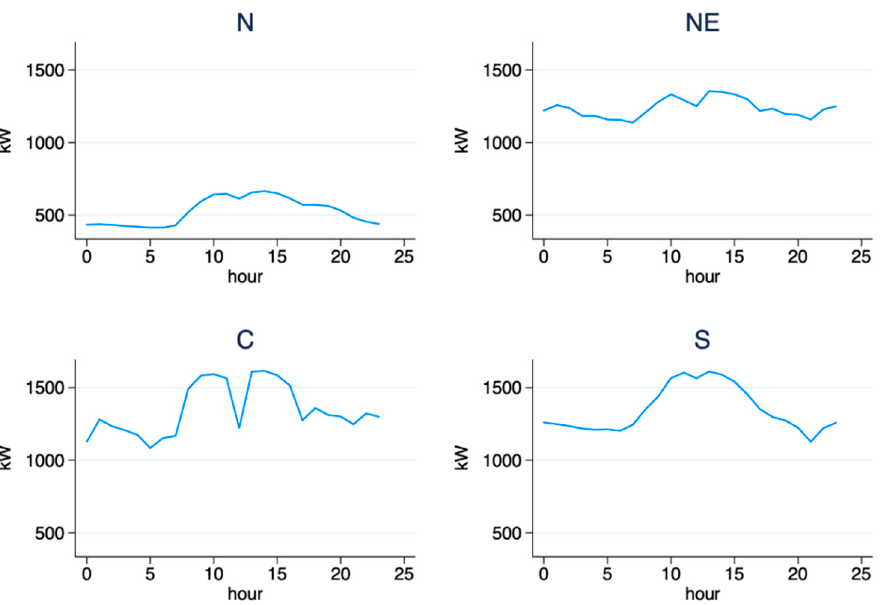
Figure A4. Hourly average load profile of LGS customers in Northern region (N), Northeastern region (NE), Central region (C), and Southern region (S).